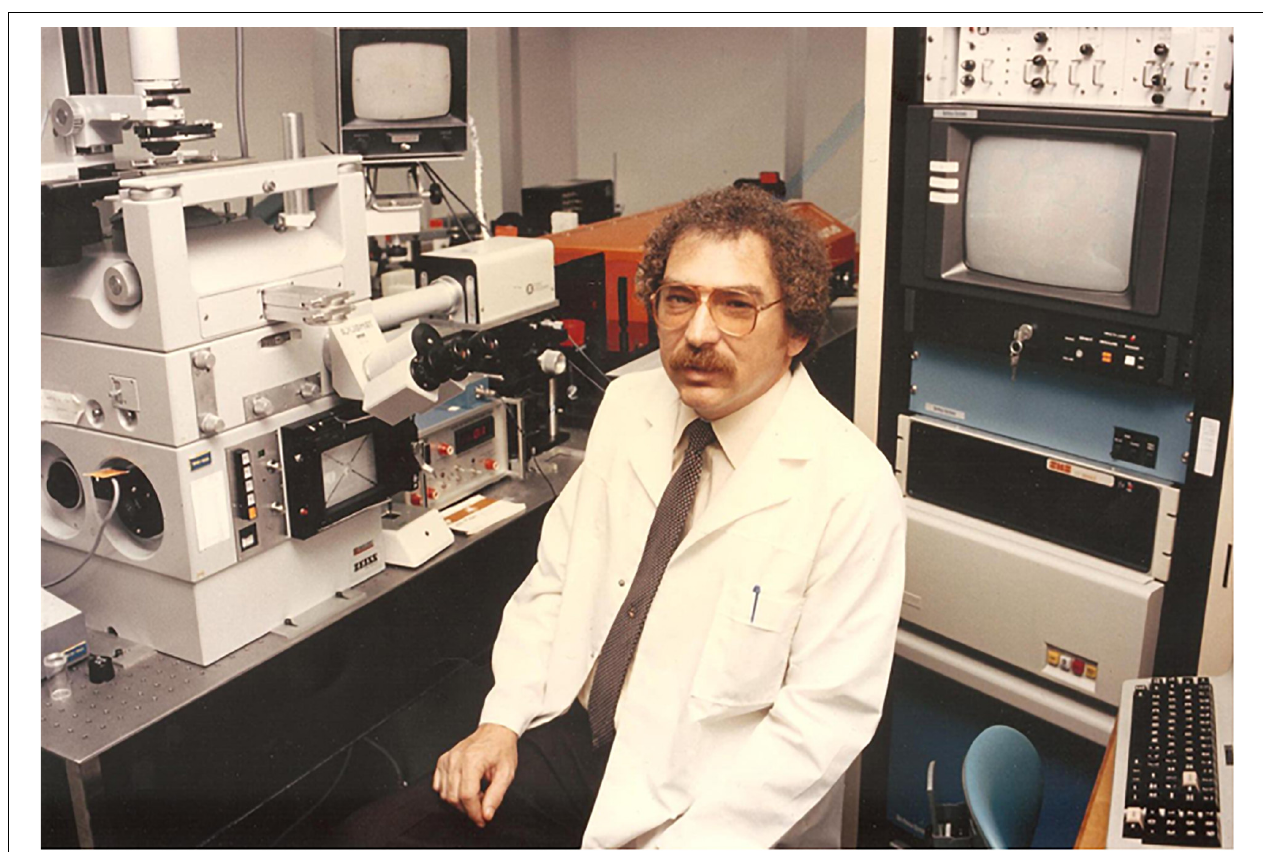
FIGURE 5 | Photograph of system and author circa 1981. The computer behind the PI (principal investigator) is an LSI-11 driven Deanza image array processor. The microscope is a Zeiss Axiovert phase contrast, polarization system. The camera is digital imaging system which signal is sent to the computer system behind the PI. See Figure 4 for details about the system components. This system was used for experiments conducted between 1980 and